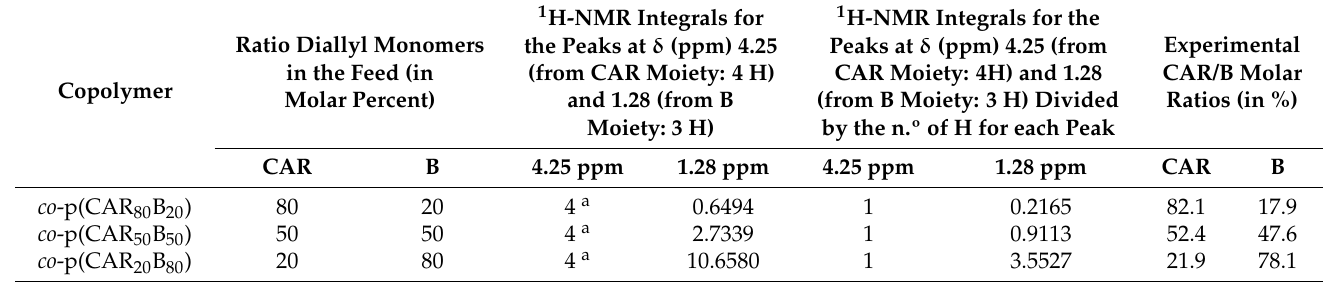
Table 3. Experimental molar ratios of constitutional repeating units for the synthesized CAR/B